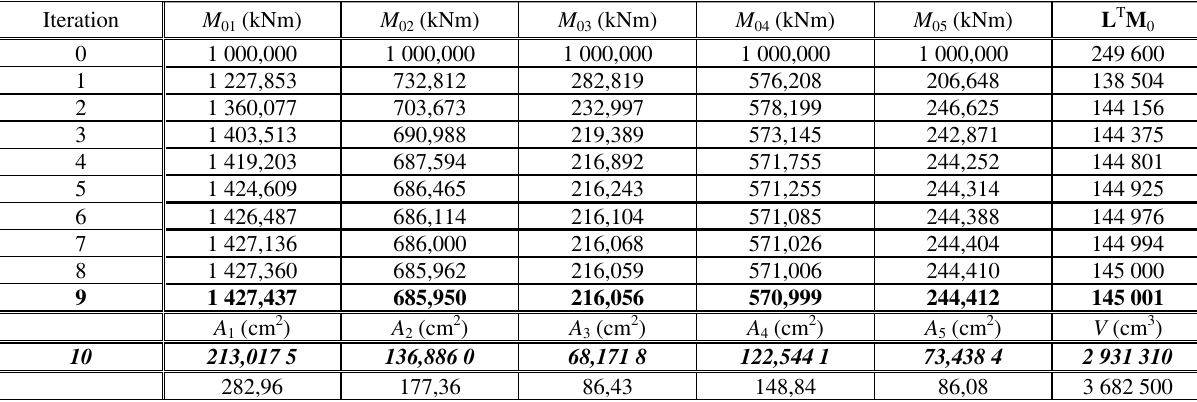
Table 2. The optimum volume of 16-storey steel frame solution convergence per iterations